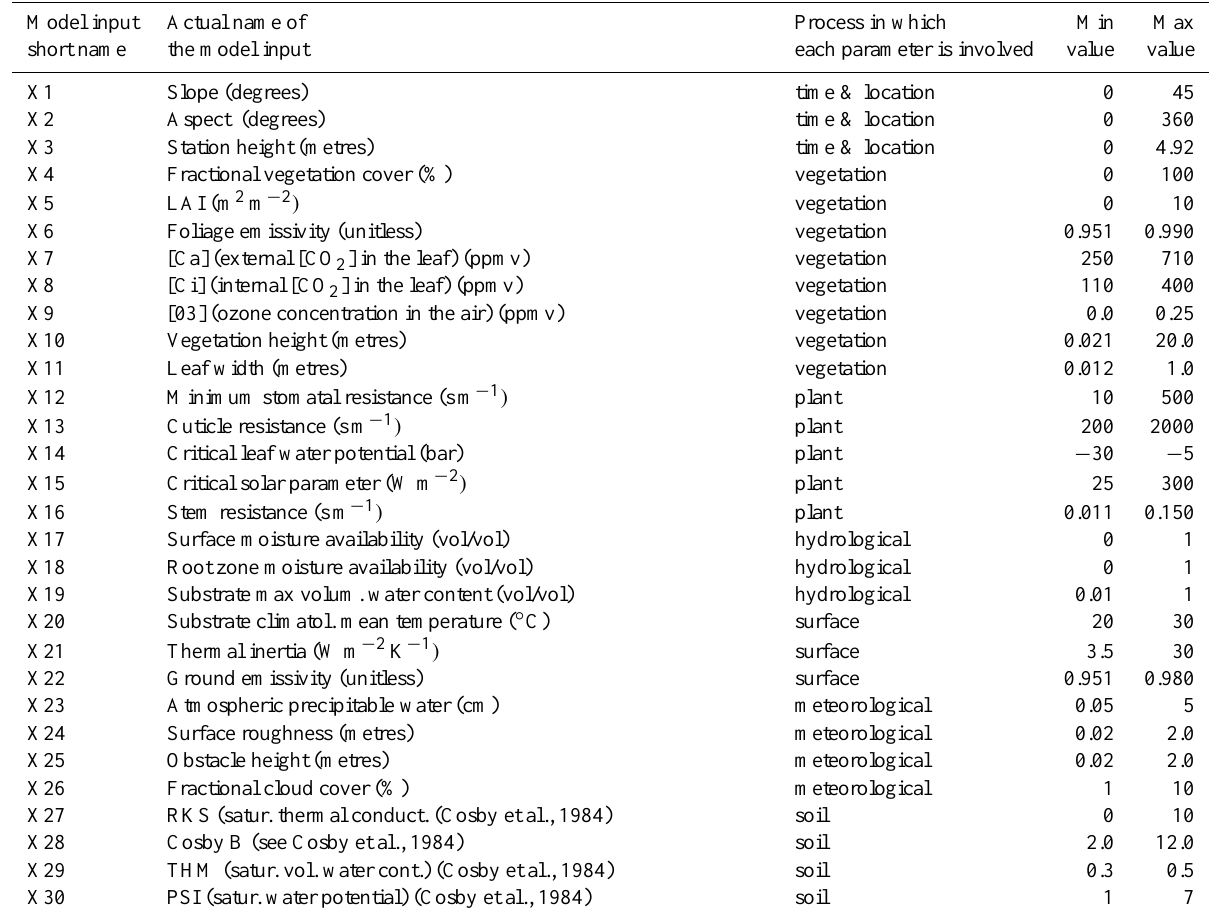
Table 1. Summary of the SimSphere inputs considered in the GSA implementation. Units of each of the model inputs, where appropriate, are provided in